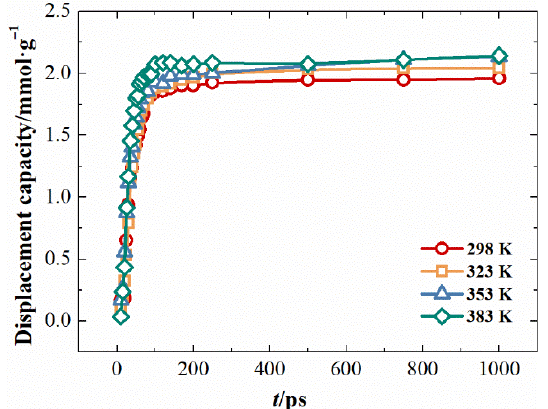
Figure 8. Displacement capacity of CH 4 by CO 2 at different temperatures over time.